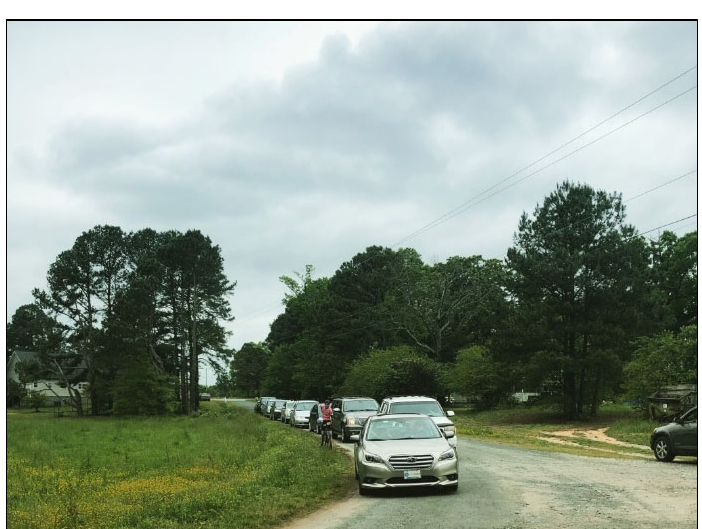
Figure 1. Ran-Lew's Socially Distanced On-farm Pick-up